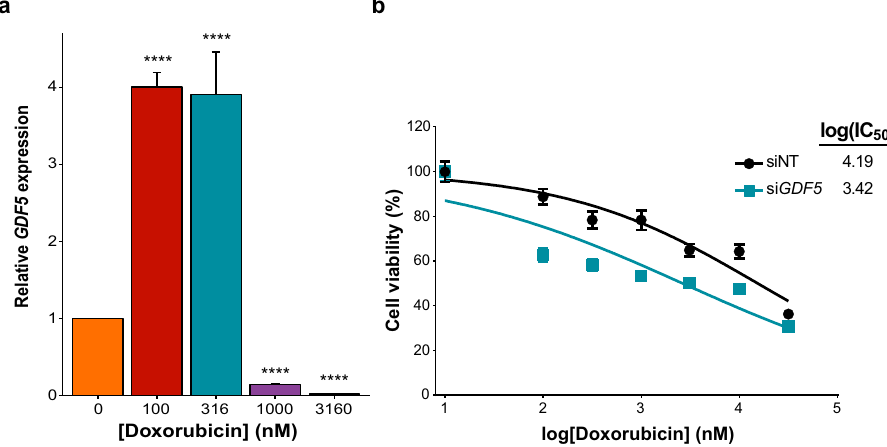
Fig. 3 In response to increasing concentrations of doxorubicin, GDF5 undergoes gene expression changes and alters HCM cell viability when silenced. a Expression levels of GDF5 at increasing concentrations of doxorubicin were measured in HCM cells, normalised to the housekeeping gene HPRT1 , and compared using one-way ANOVA to baseline (0 nM doxorubicin). Two independent experiments were performed (total n = 6) and their results combined. **** P < 0.0001 after Bonferroni multiple testing correction. Data are presented as mean and standard deviation. b Expression levels of GDF5 were silenced with RNAi and HCM cell viability at increasing concentrations of doxorubicin was measured using an MTT assay ( n = 5). Dose-response curves were fi tted to a non-linear regression, log(inhibitor) versus normalised response 4 parameter model and data are presented as mean and standard deviation. siNT represents negative control non- targeting siRNA. The logarithm of the half maximal inhibitory concentrations (IC 50 ) are